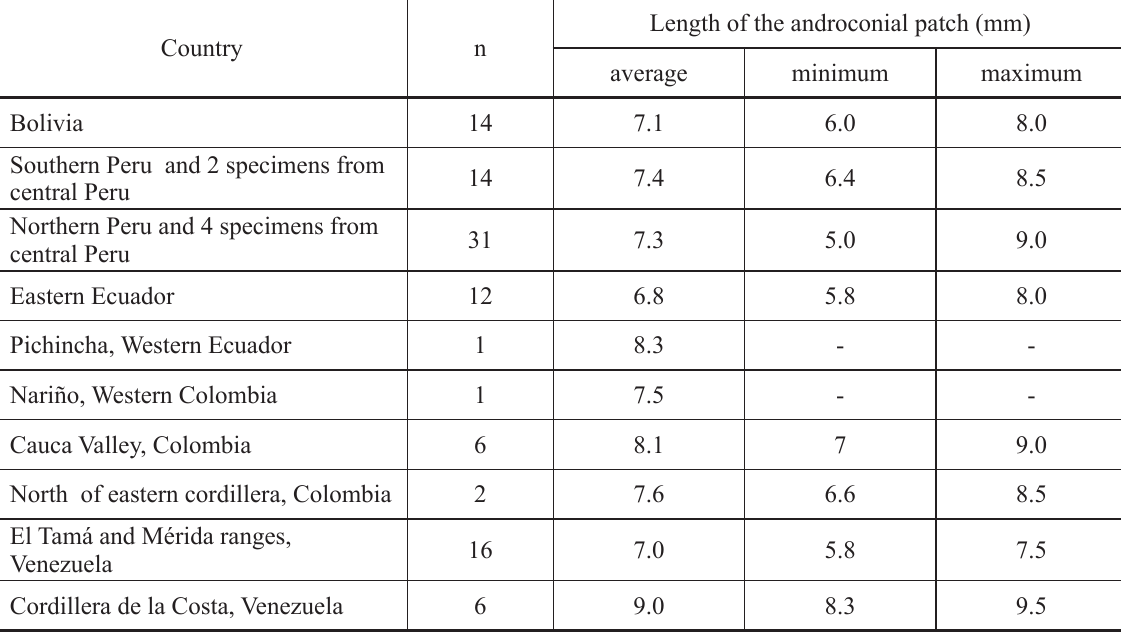
Table 4. Variations of the length of the male HW androconial patch (n = number of individuals on which measurements have been made, directly or on scaled pictures).